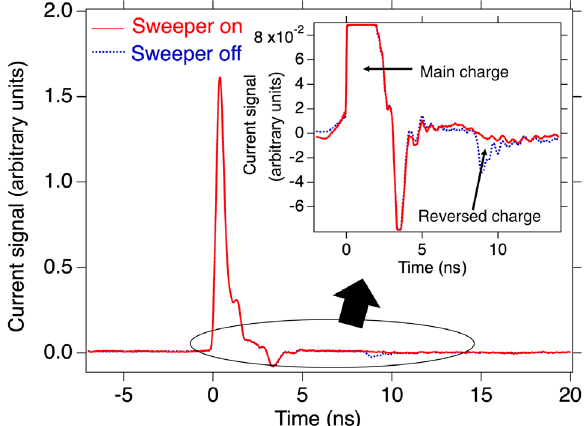
FIG. 7. Current monitor signals measured between the 476 MHz rf cavity and the L-band accelerator of the injector section. Red solid and blue dotted lines correspond to sweeper on and off, respectively. An enlarged view is inserted to show the reversed charge having opposite polarity at 9 ns after the main